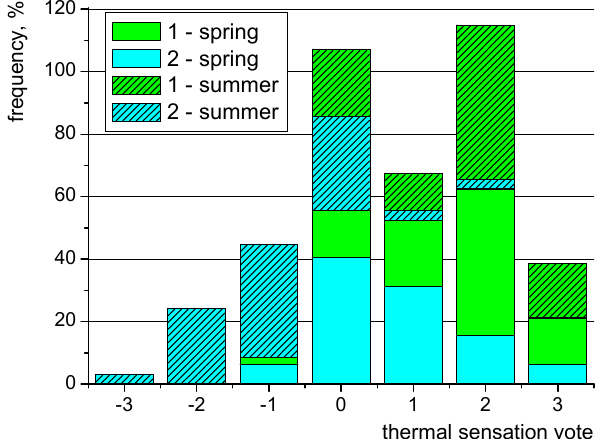
Figure 17. Thermal sensation votes in room 1.03/1.08 of the traditional “A” building (1) and in room 3.20/4.09 of the intelligent “Energis” (2).